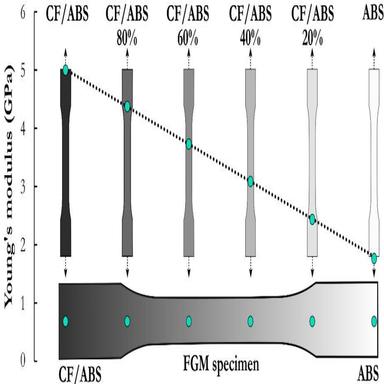
Graphical representations of concentrations of ABS and CF/ABS materials fabricated to test mechanical behavior of heterogeneous blends and provide understanding of the gradual change of Young's modulus at specific locations on the FGM specimen (arrows show the loading directions).